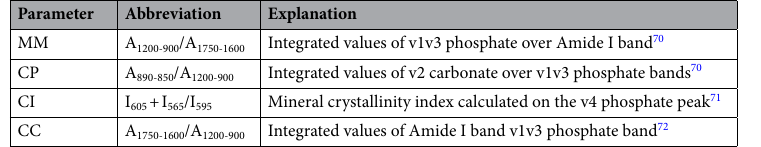
Table 4. ATR-FTIR variables. Description of the semiquantitative analysis of FTIR spectra (A: area of the peak; I: intensity of the peak: MM: mineral to matrix ratio; CP: carbonate to phosphate ratio; CI: crystallinity index; CC: collagen